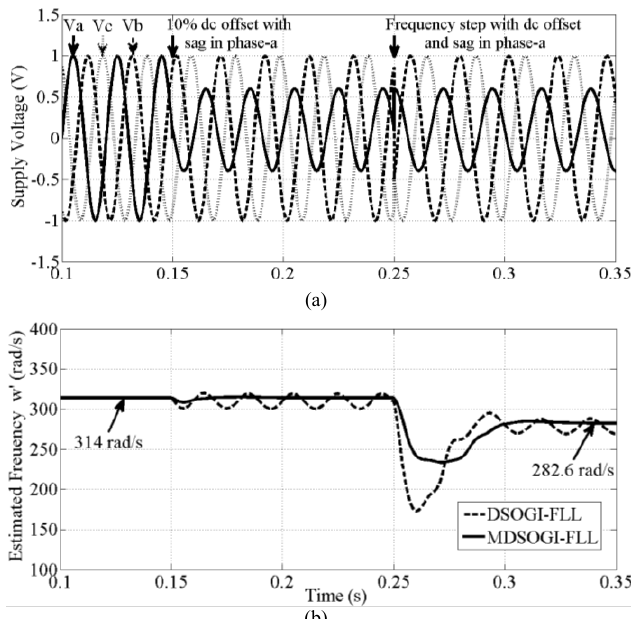
(b) Fig. 6. Performance under unbalanced sag conditions: (a) Three-phase grid voltage signals (b) Estimated frequency.